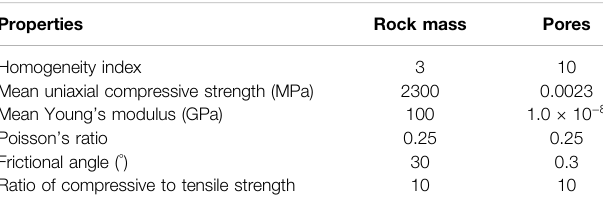
TABLE 2 | The physical and mechanical properties of the numerical models utilized in RFPA 2D .